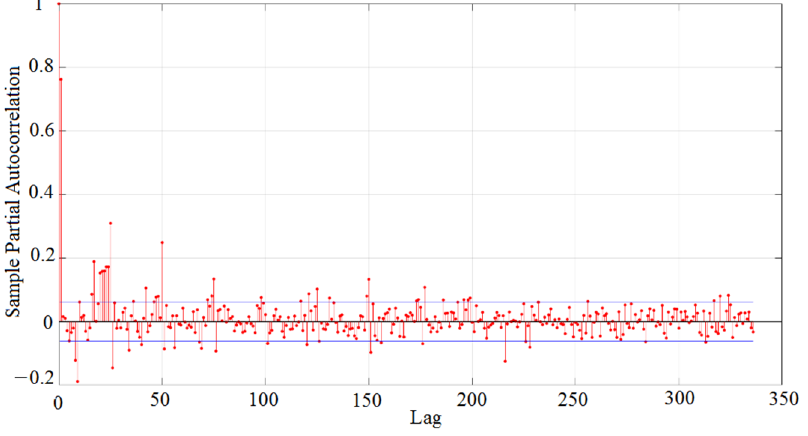
Figure 14. PACF plot for household demand for two-week time